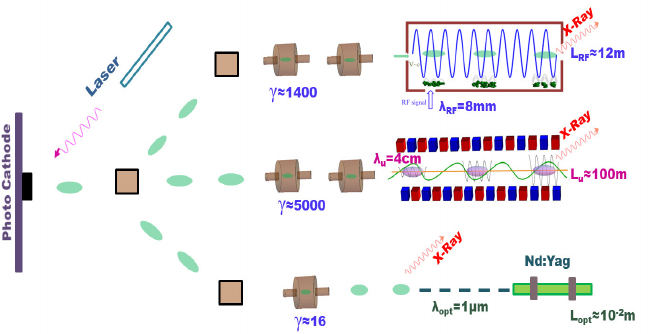
Figure 1. Comparison between Laser Wave (or optical), magnetic and RF undulators from bottom right to top right, respectively, for an output of X-ray radiation with λ r = 1 nm. The figure reports an electron beam emitted from the photocathode to the “undulator”, after a suitable acceleration. The expected undulator lengths and the e-beam energies necessary to reach the SASE-FEL performances are underlined